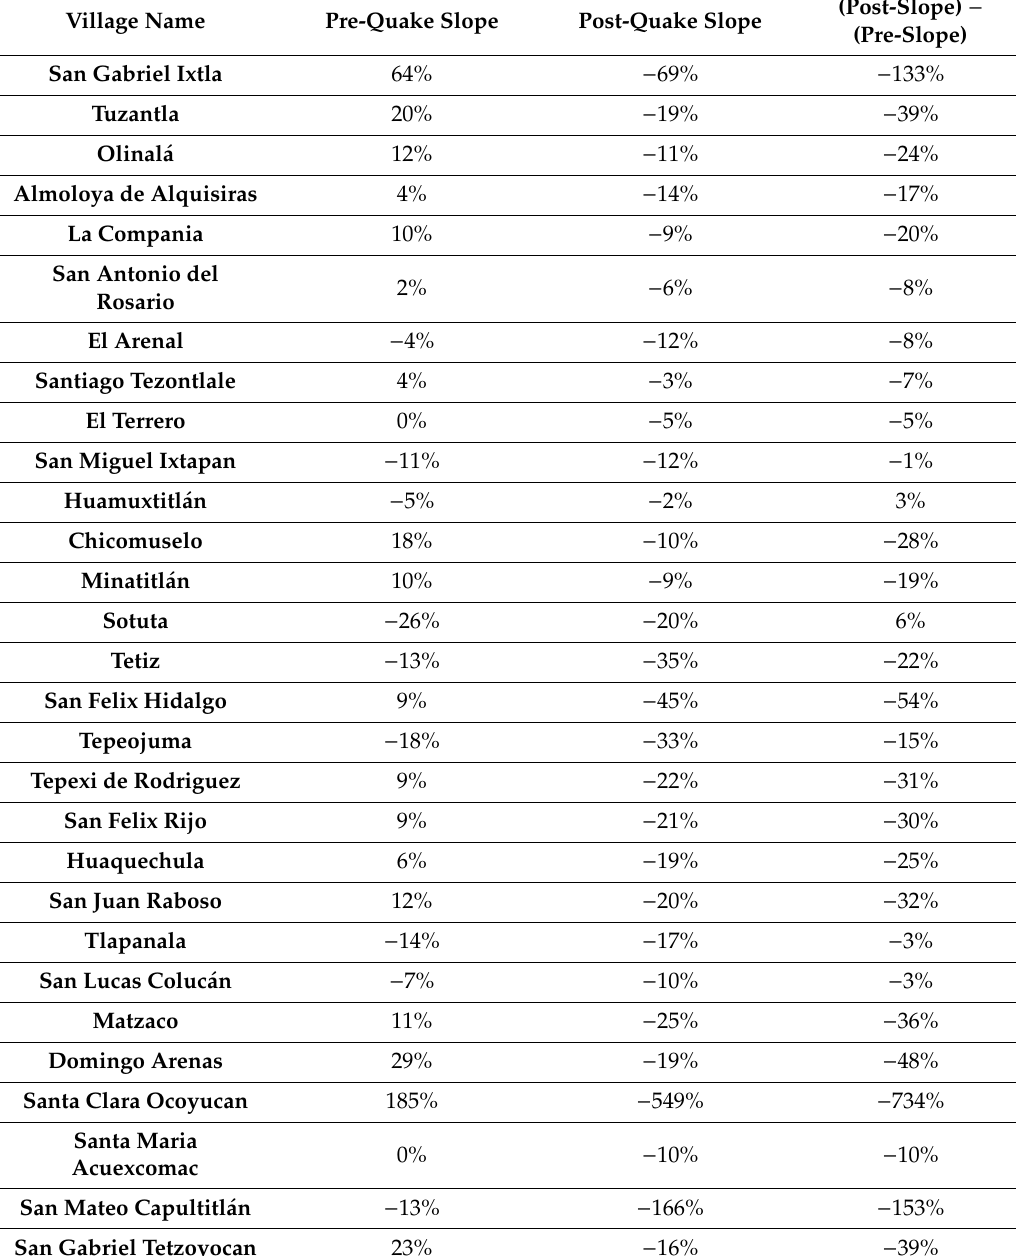
Table A5. A locality was determined as depopulating if the pre-earthquake slope of residents was 24% lower than the post-earthquake slope of